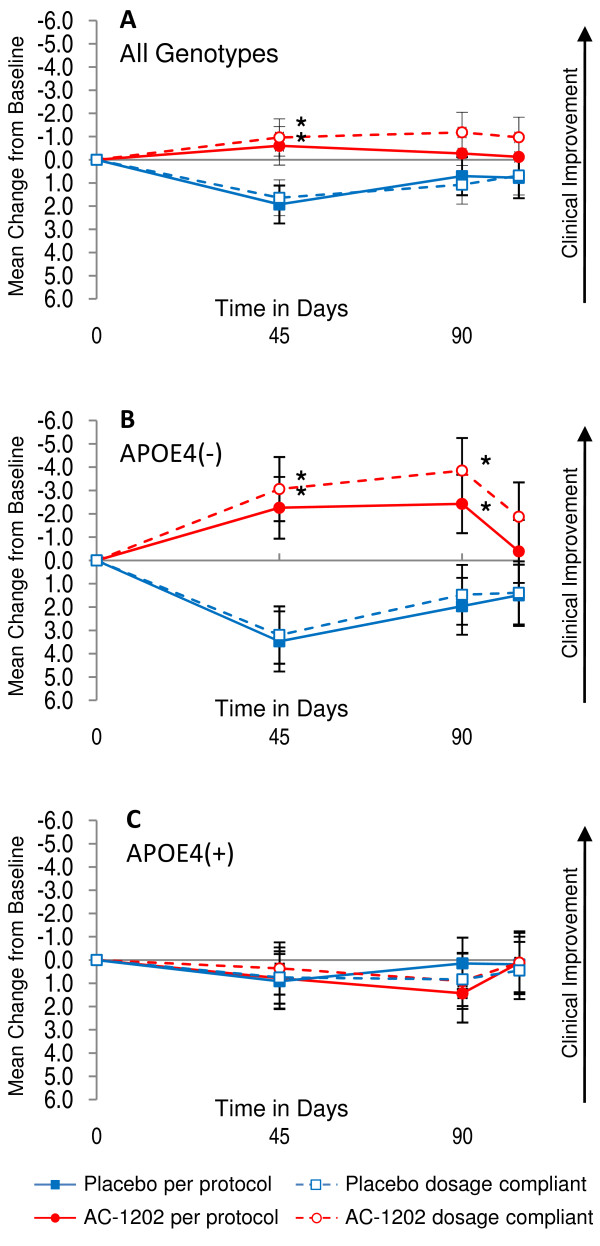
Mean change in ADAS-Cog scores from Baseline in per protocol and dosage compliant populations without LOCF and stratified by APOE4 carriage status. Y axis is change from Baseline. X axis is time in days. Solid red circles and lines represent per protocol subjects taking AC-1202. Solid blue squares and lines represent per protocol subjects taking Placebo. Open red circles and dashed lines represent dosage compliant subjects taking AC-1202. Open blue squares and dashed lines represent dosage compliant subjects taking Placebo. Error bars represent standard error of the mean. Asterisks (*) indicate a significant (p-value < 0.05) difference in mean change from Baseline between AC-1202 and Placebo. A) Per protocol and dosage compliant subjects administered AC-1202 regardless of genotype, both cohorts demonstrate a significant difference from Placebo at Day 45. B) Per protocol and dosage compliant subjects lacking the APOE4 allele (APOE4(-)) and administered AC-1202 demonstrate a significant difference from Placebo at both Days 45 and 90. C) Per protocol and dosage compliant subjects carrying the APOE4 allele (APOE4(+)) do not differ at any time point. For number of subjects, confidence intervals, and p-values, see Tables 6 and 7.